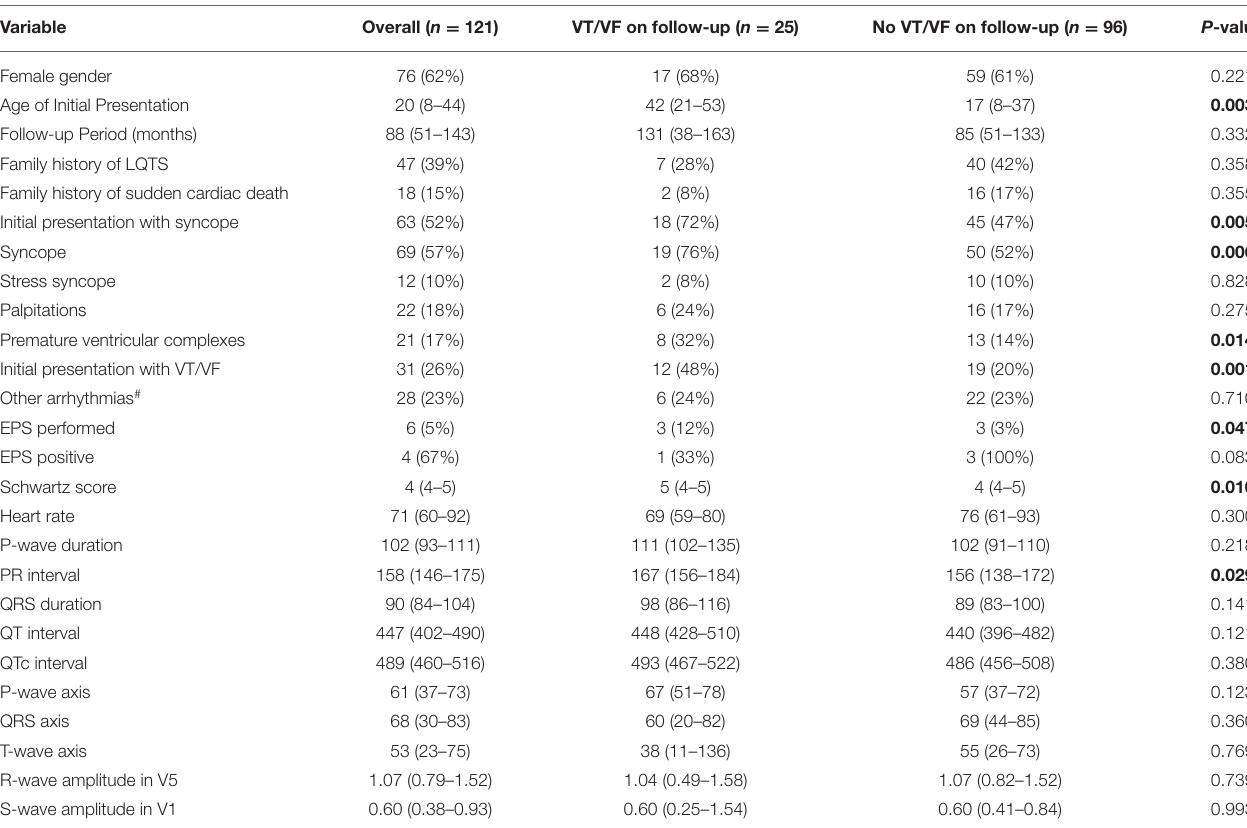
TABLE 1 | Baseline clinical characteristics and electrocardiographic variables of the included subjects.